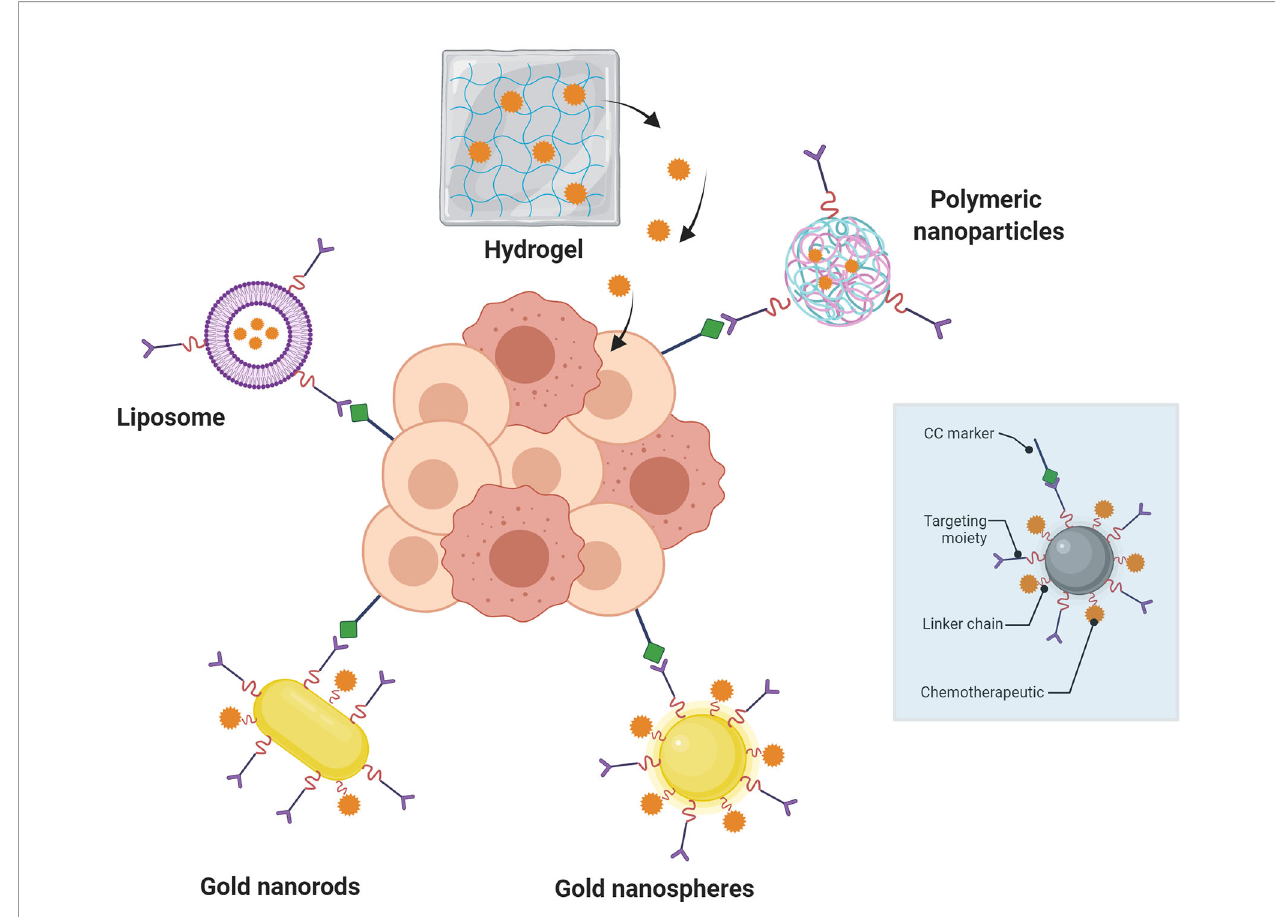
FIGURE 2 | Nanoparticle-mediated targeted drug delivery to cancer cells (center, darker pink circles). Nanoparticles (blue box) containing targeting moieties bind to cancer cell (CC) markers on tumors to inhibit/agonize signaling or protein binding and/or deliver therapeutic drugs (red jagged spheres; e.g., small molecules or antibodies). Linkers are important components of the design for distance and physiochemical property